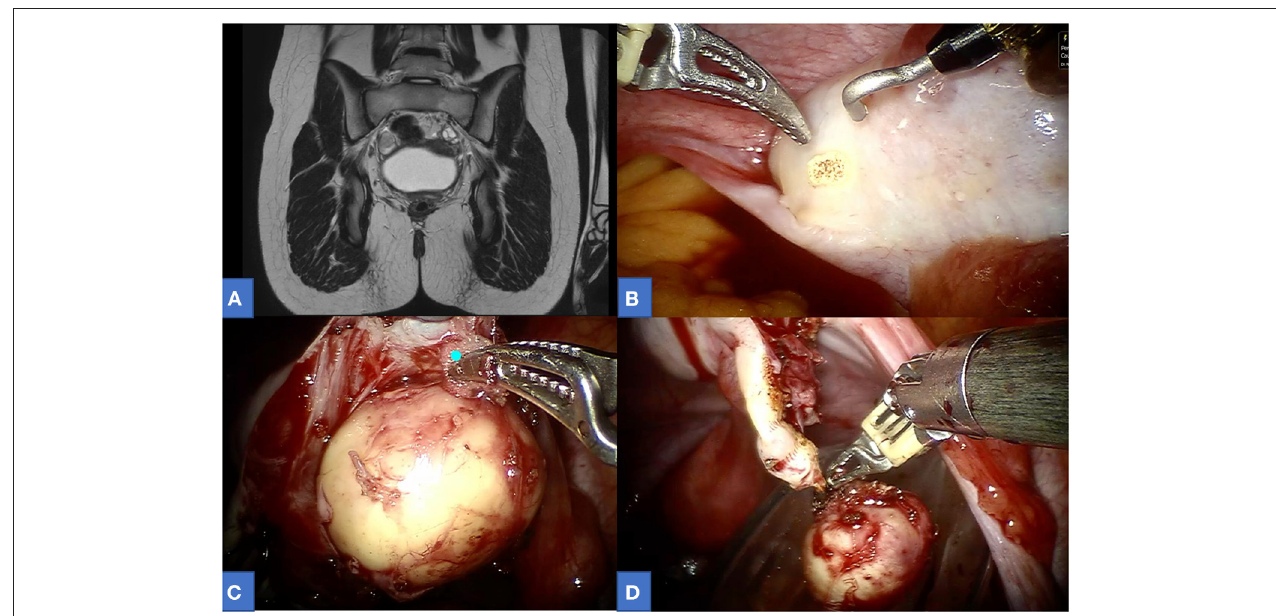
FIGURE 1 | A 13-year-old affected by right ovarian mature teratoma. (A) Preoperative MRI. (B–D) Intraoperative view.